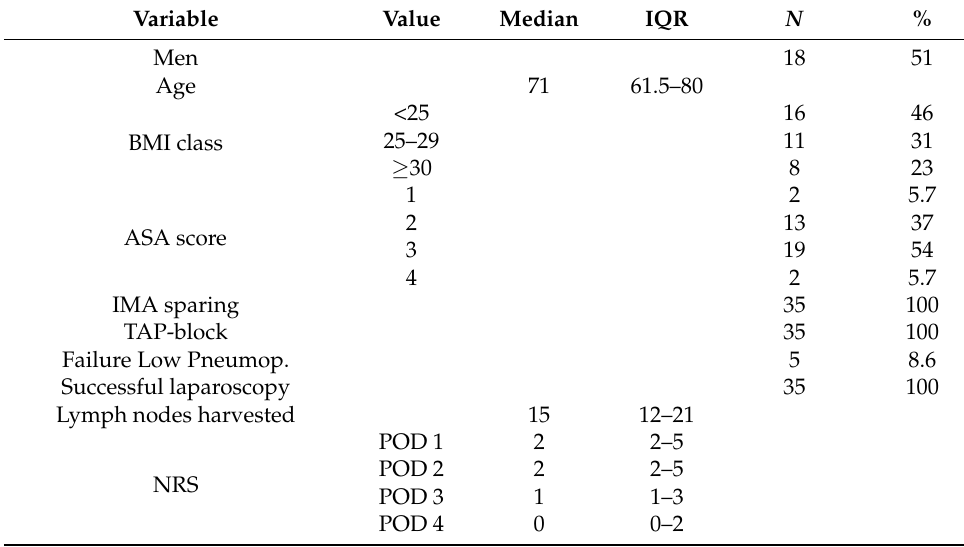
Table 6. Monza subgroup patients’